Question: Write a single sentence explaining what this figure depicts.
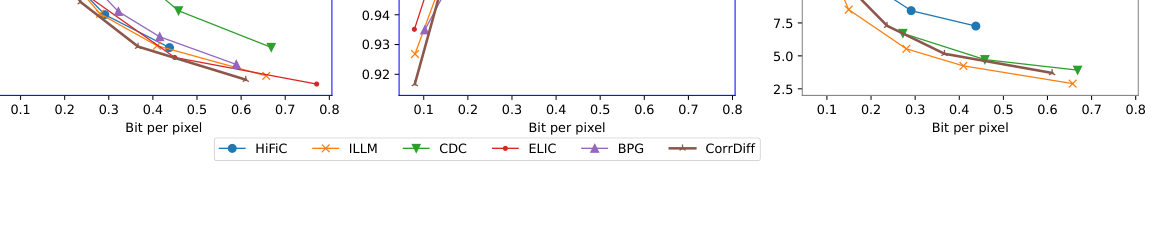
Answer: performance of diverse metrics on DIV2K test dataset. [Zoom in for best view]